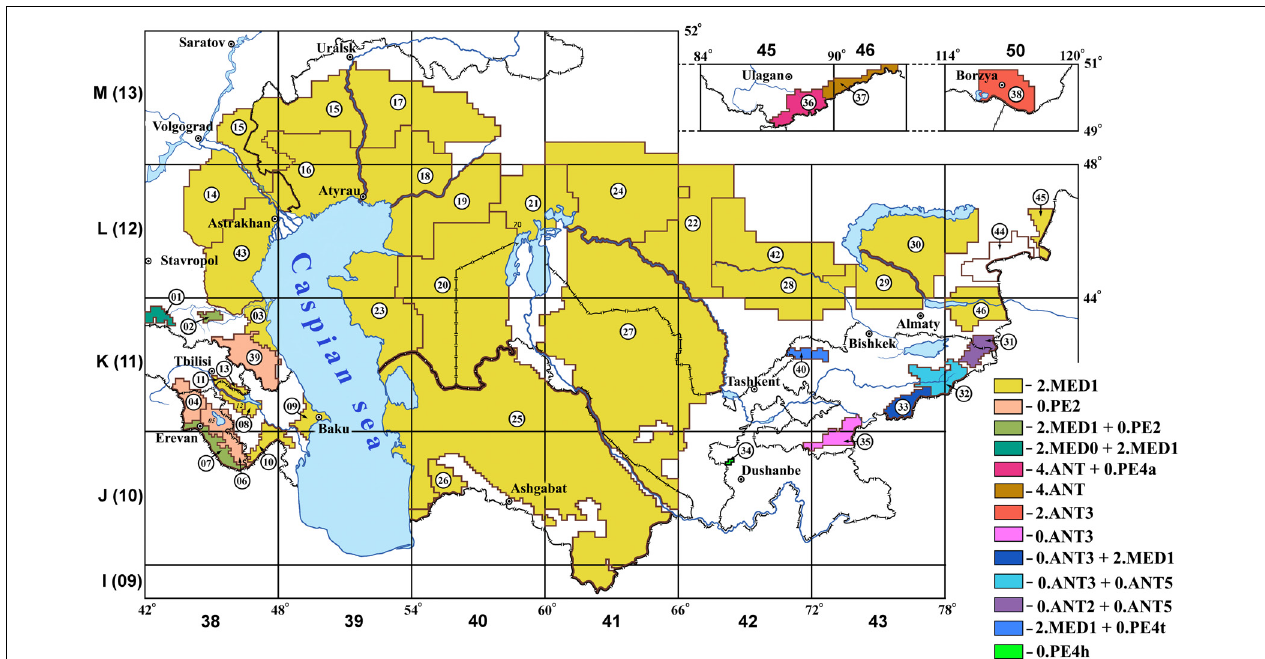
FIGURE 1 | Phylogenetic appurtenance of Yersinia pestis strains from CIS plague foci. The index number corresponds to the classification of foci, applied in CIS countries.